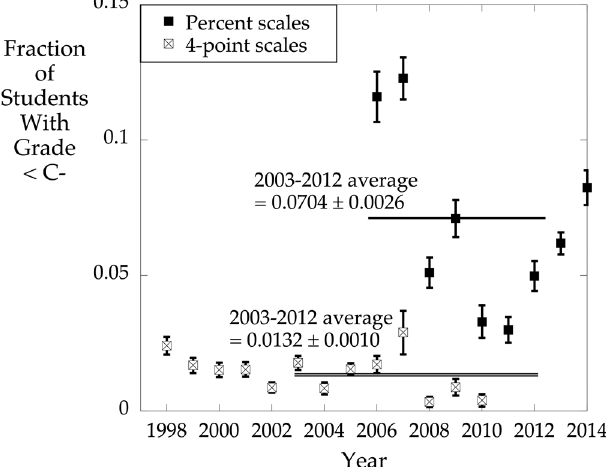
FIG. 2. Fraction of students receiving a course grade less than C − as a function of year they took the course. The two main grade scales used in the course are shown separately. The error bars are (cid:2) standard